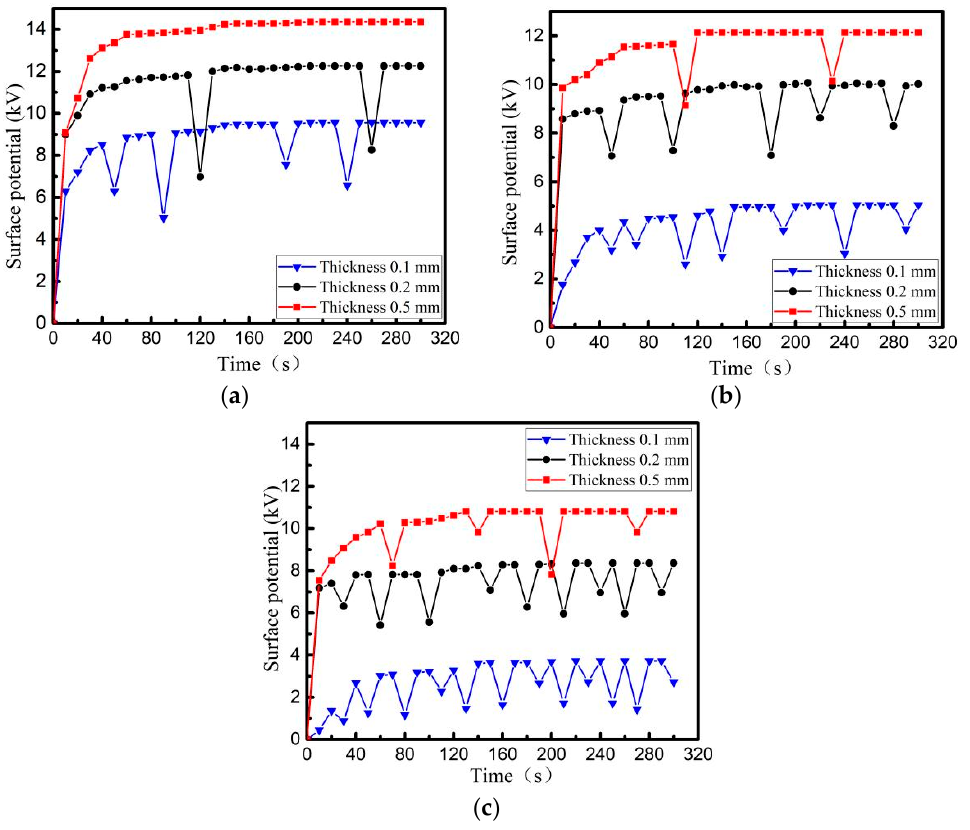
Figure 9. Surface potential of dielectric surface with different thickness without external field radiation ( a ) PTFE, ( b ) PI, ( c ) EP.